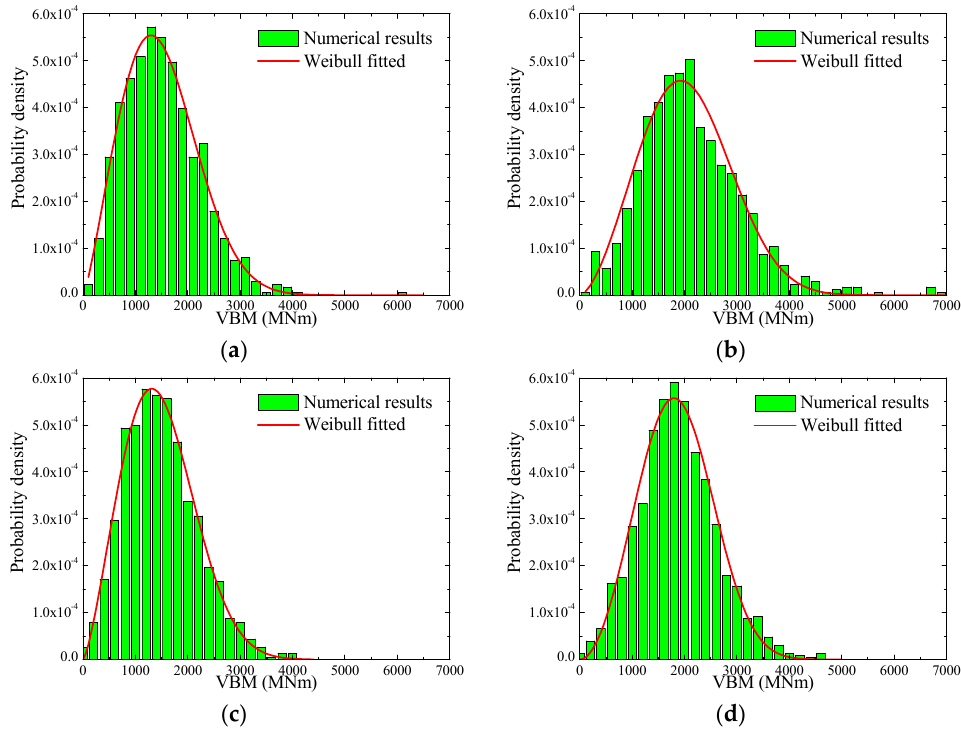
Figure 14. The histogram of VBM peak distribution. ( a ) Nonlinear hogging VBM; ( b ) nonlinear sagging VBM; ( c ) linear hogging VBM; ( d ) linear sagging VBM. Appl. Sci. 2019 , 9 , x FOR PEER REVIEW